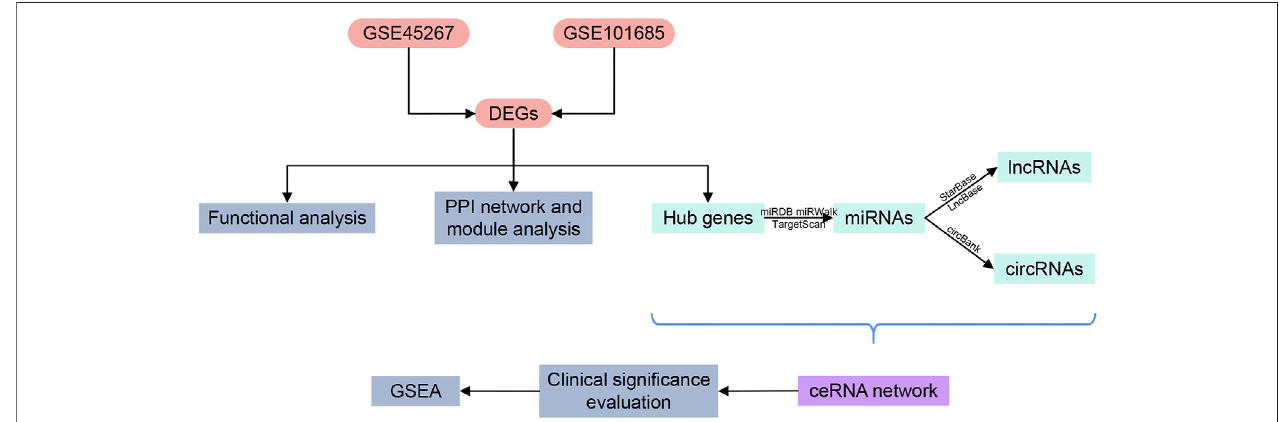
FIGURE 1 | Flowchart of the research design. DEGs, differentially expressed genes; PPI, protein-protein interaction; miRNAs, microRNAs; lncRNAs, long non-coding RNAs; circRNAs, circular RNAs; ceRNA, competing endogenous RNA; GSEA, gene set enrichment